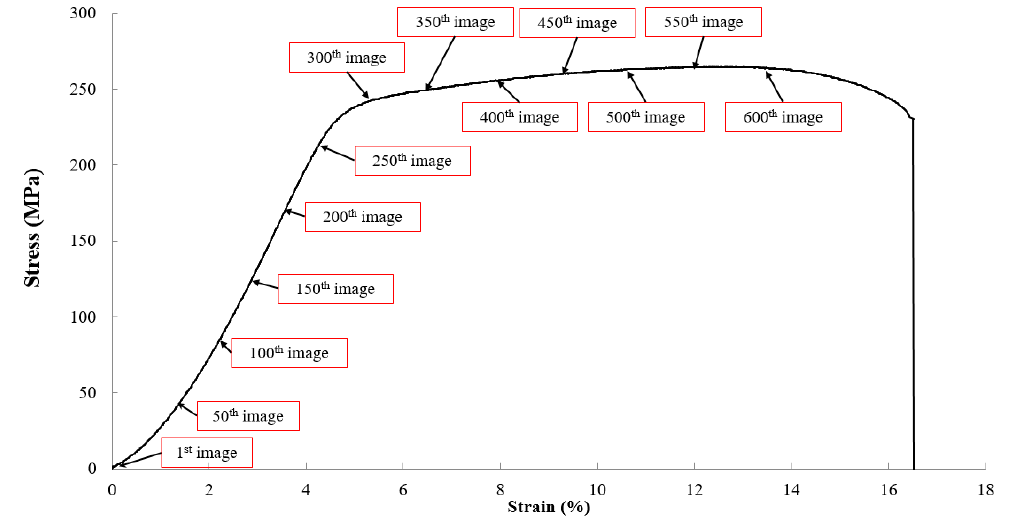
Figure 7. Strain–stress curve from the load cell and extensometer data.